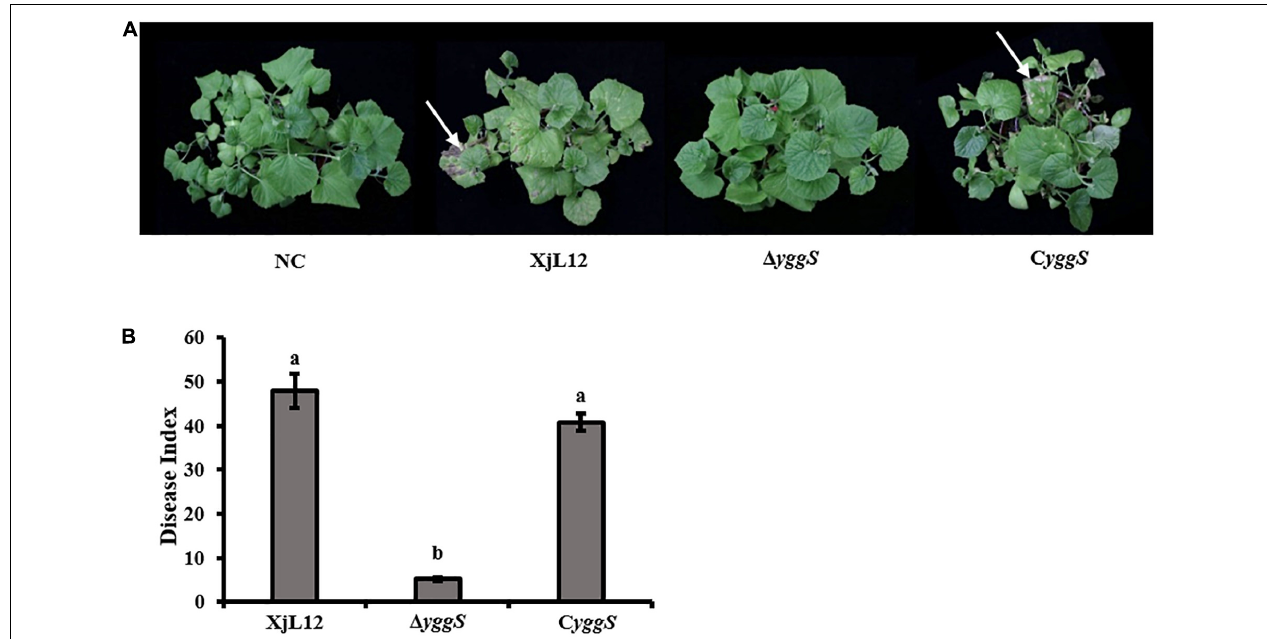
FIGURE 2 | Spray inoculation assay. (A) A. citrulli suspension ( ∼ 1 × 10 8 CFU/mL) were inoculated onto the euphylla of melon by spray inoculation. The phenotypes were photographed after the melon seedlings were allowed to grow for 7 days after inoculation. The red arrows indicate the BFB symptoms. (B) Disease index for each treatment is represented by a histogram. The bars represent means and lines indicate standard errors of the mean. XjL12: wild-type strain, (cid:49) yggS : yggS deletion mutant; C yggS : complemented strain of (cid:49) yggS . Letters above each bar represent significant differences as determined by the LSD test ( P < 0.05).